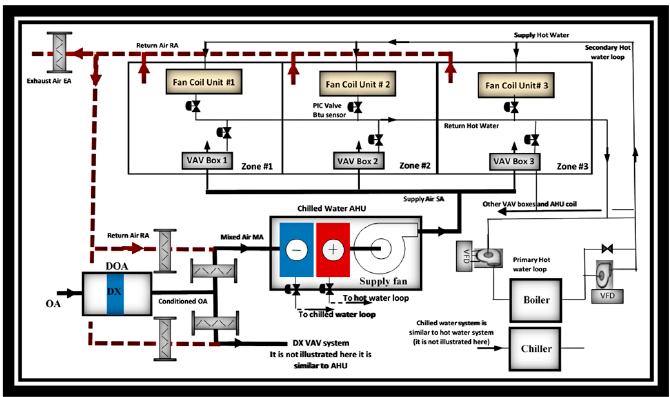
Figure 11. Schematic of HVAC system lab.